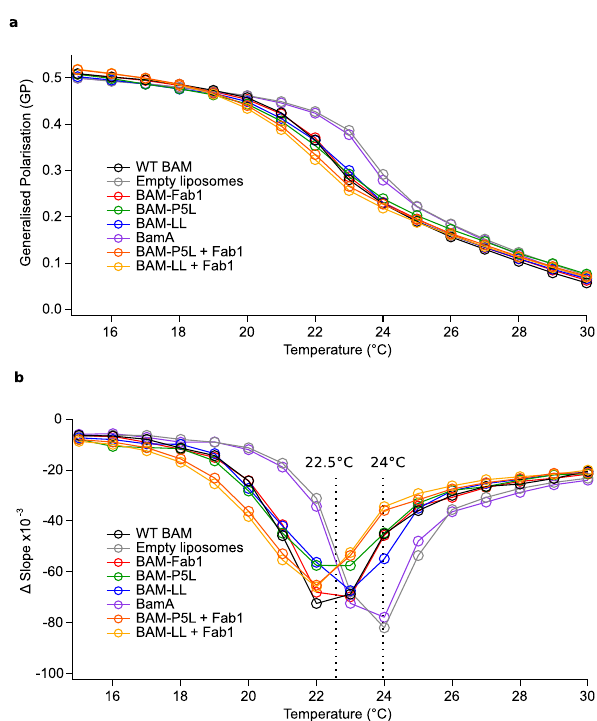
Fig. 5 BAM variants reduce the phase transition temperature of DMPC liposomes. Global lipid phase transition behaviour for each BAM variant and BamA in DMPC proteoliposomes, with an empty liposome control measured using laurdan fl uorescence. a The ratio of laurdan fl uorescence at 440 and 490 nm was plotted as generalised polarisation (GP, see the “ Methods ” section) against temperature for 0.8 µ M BAM/BamA proteoliposome suspensions at a 1600:1 (mol/mol) lipid-to-protein ratio (LPR) with added laurdan (at a 305:1 lipid-to-laurdan ratio) in TBS pH 8.0. b The fi rst derivative of data shown in a showing the transition temperature for each liposome suspension as the point of steepest (most negative) gradient. Whilst empty DMPC ( grey ) and BamA proteoliposomes ( purple ) have a transition temperature of 24°C, the presence of WT BAM ( black ), BAM-Fab1 ( red ), BAM-P5L ( green ), BAM-LL ( blue ), BAM-P5L + Fab1 (orange) and BAM-LL + Fab1 (yellow) broaden the phase transition and lower the transition temperature. Figures labelled with “ BAM ” refer to the full BAM complex (BamABCDE), whilst “ BamA ” is just BamA alone. This experiment was performed once for each variant shown. Source data for a and b are provided as a source data fi